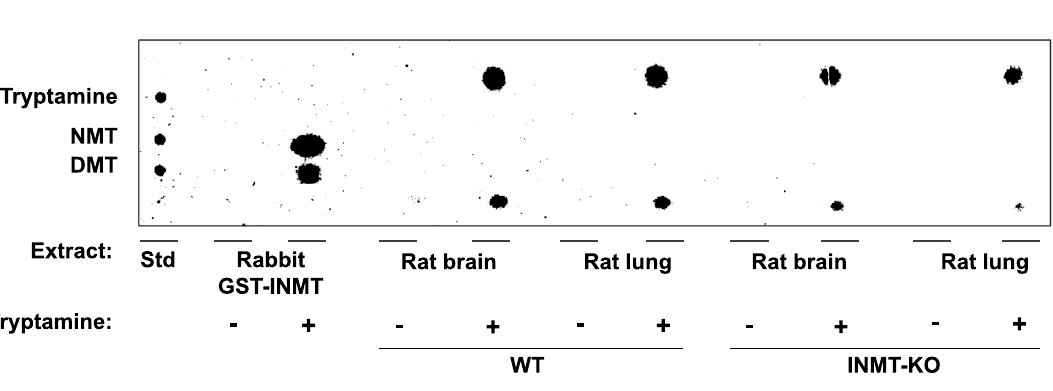
Figure 3. Brain and lung tissues from WT and KO rats produce products that are not isographic with NMT or DMT. Phosphor imaging scan of radiometric enzyme assay products using extracts from brain and lung tissues of WT and KO rats following separation on silica gel plates using a mobile phase of N -butanol:acetic acid:water (12:3:5). A standard mixture (Std) containing tryptamine, NMT and DMT were clearly separated using these